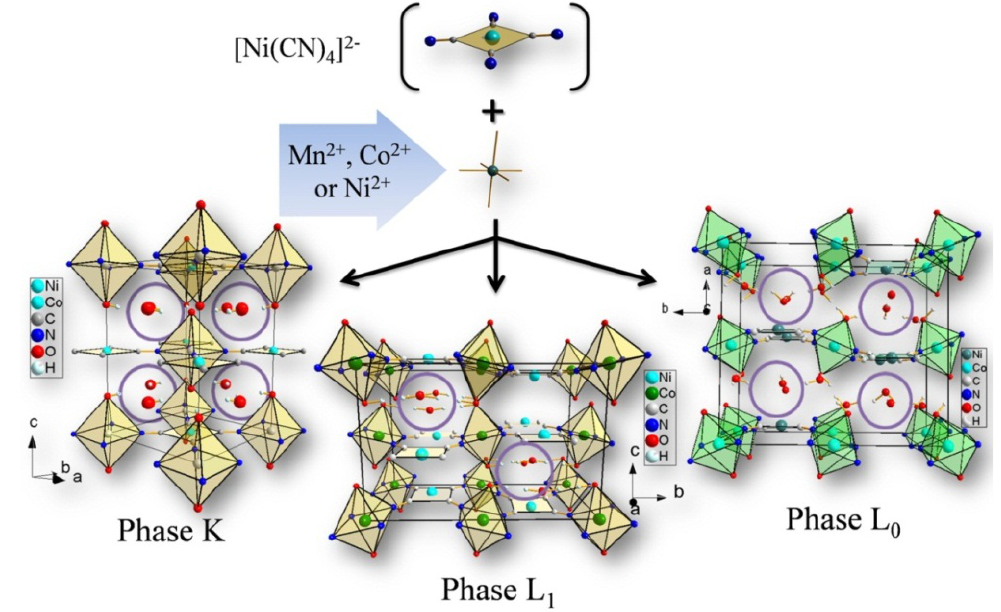
Figure 1. Schematic representation of the assembling process in order to obtain the K, L and L phases. The hydrogen-bonded water molecules are highlighted within open circles 0 in the interlayers region, while the rest of the oxygen atoms (in red) correspond to coordinated water molecules (two per unit